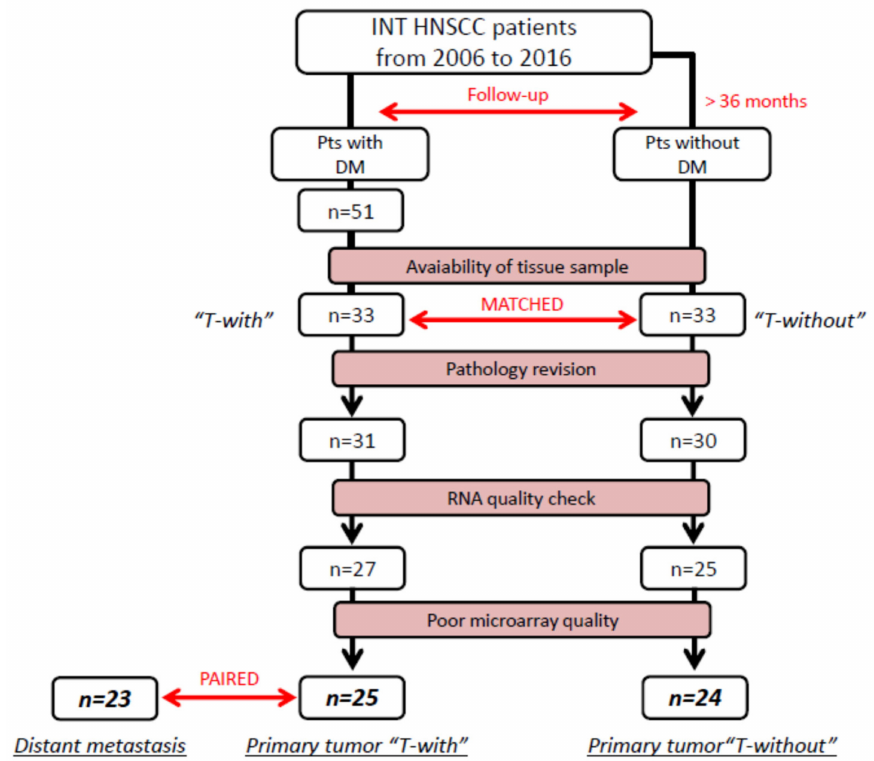
Figure 1. Study population recruitment. Sample selection criteria resulting in 25 T-with and 24 T-without tumors available for gene expression analysis. Table 1. Demographic and clinical characteristics. p -values were computed by Fisher’s exact tests (categorical data) and Wilcoxon rank-sum tests (numerical